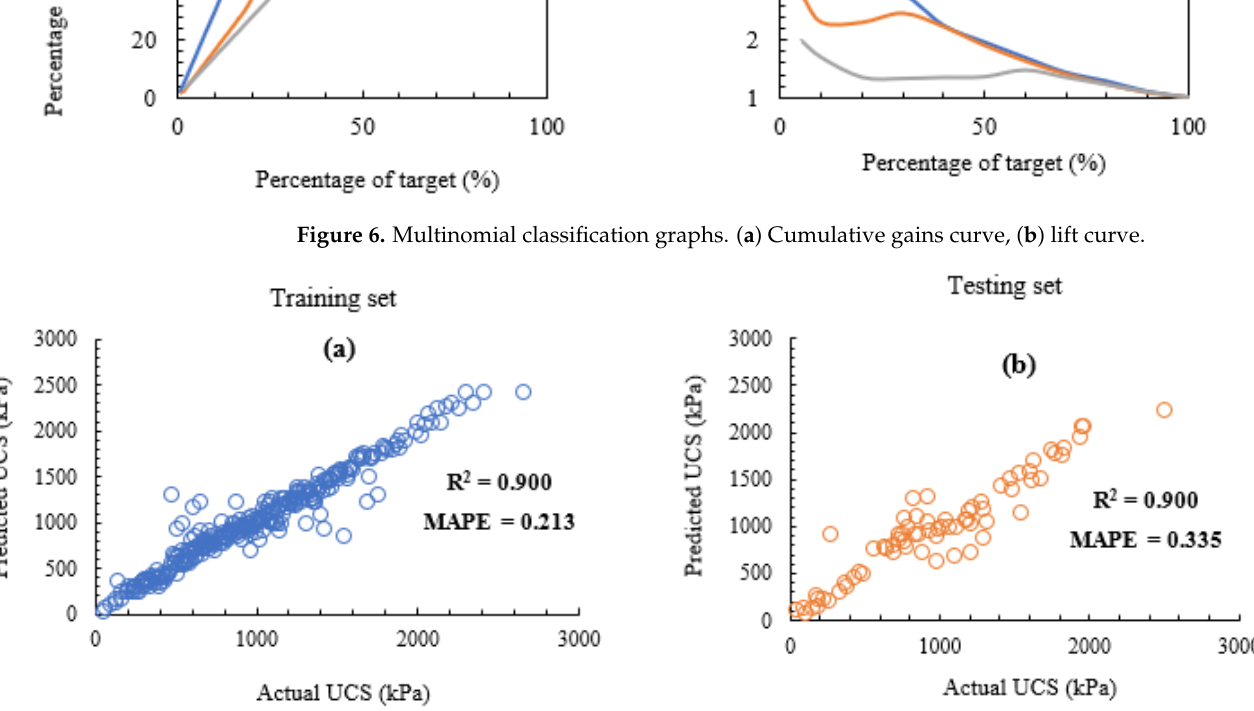
Figure 7. Regression curves. ( a ) Training set, ( b ) testing